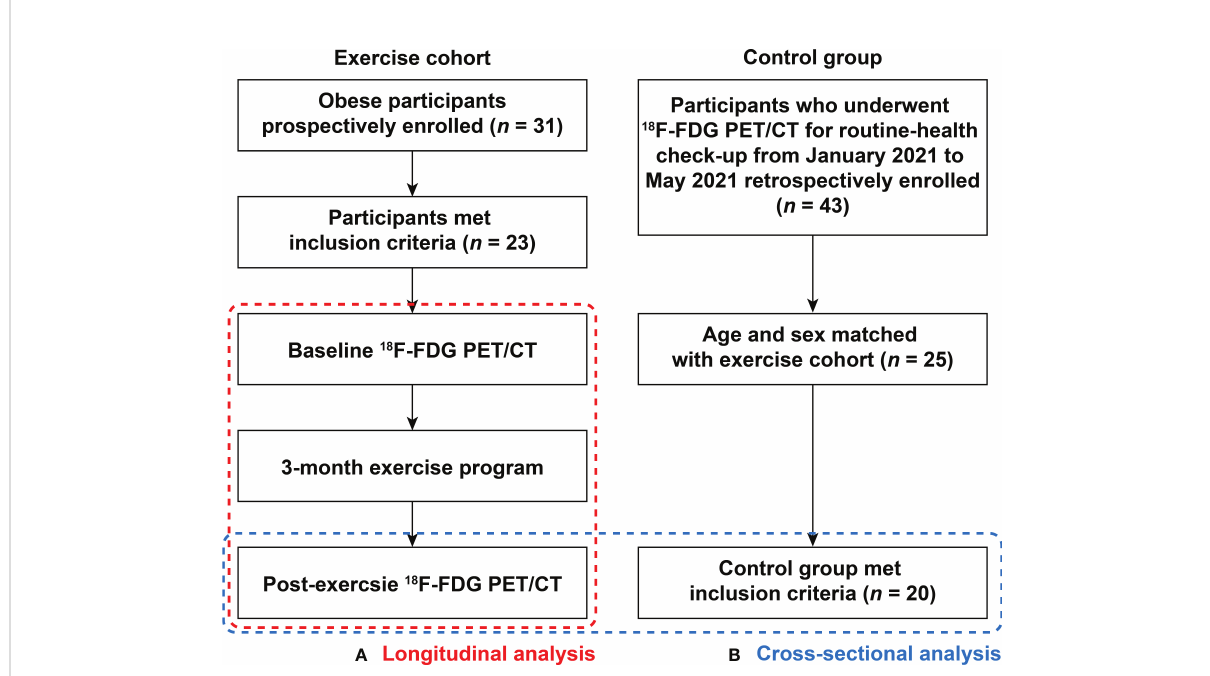
FIGURE 1 Flow chart showing enrollment scheme. This study was composed of two types of investigations: (A) Longitudinal analysis within the obese women exercise cohort from baseline to 3-month after completion of scheduled exercise; and (B) Cross-sectional analysis of post-exercise obese women and non-obese control group. 18 F-FDG PET/CT, 18 F- fl uorodeoxyglucose (FDG) positron emission tomography/computed tomography